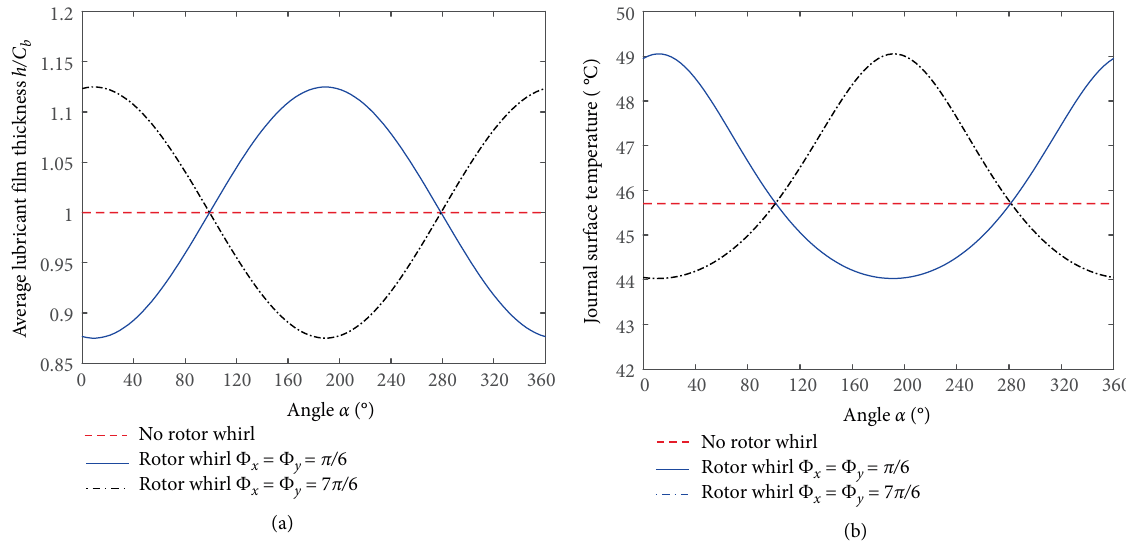
Figure 2: Calculation results. (a) Average lubricant film thickness distribution and (b) journal surface temperature distribution.